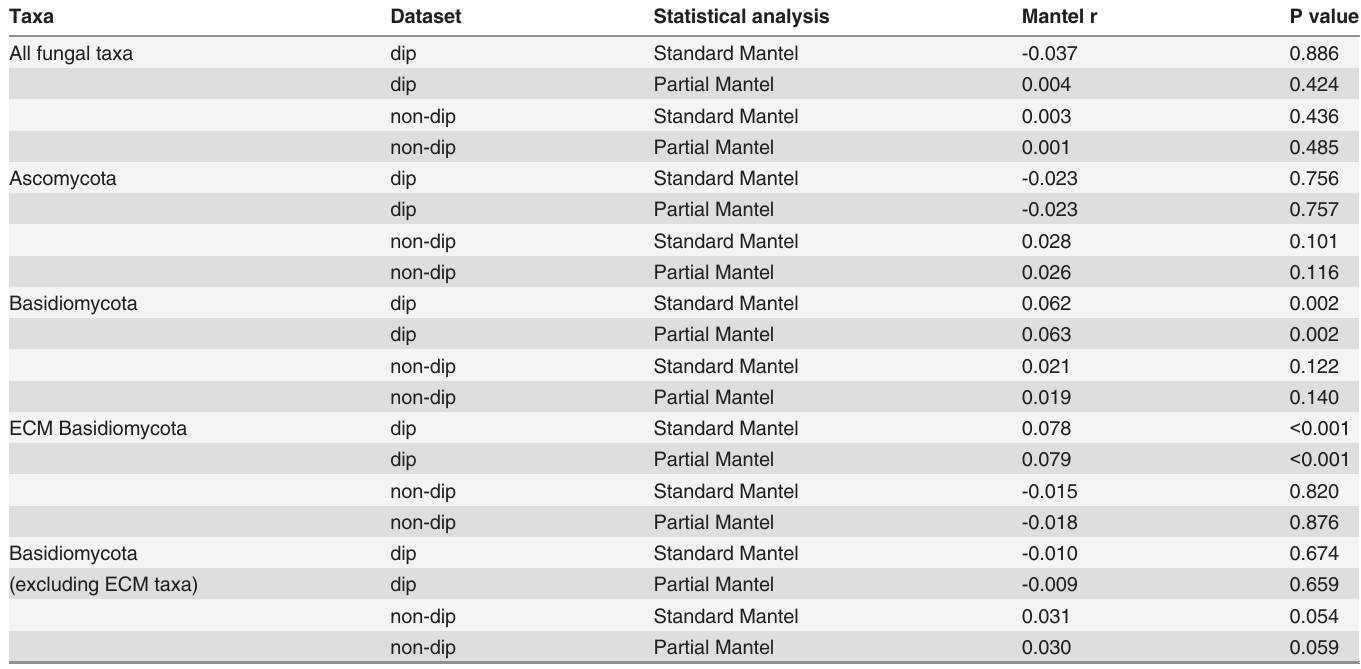
Table 2. Results of standard and partial Mantel tests between community dissimilarity of fungi and genetic distance of host plants. Mantel tests were performed for dipterocarp (dip) and non-dipterocarp (non-dip) datasets separately. In partial Mantel tests, correlation between the two vari- ables was tested after controlling for the effect of geographical